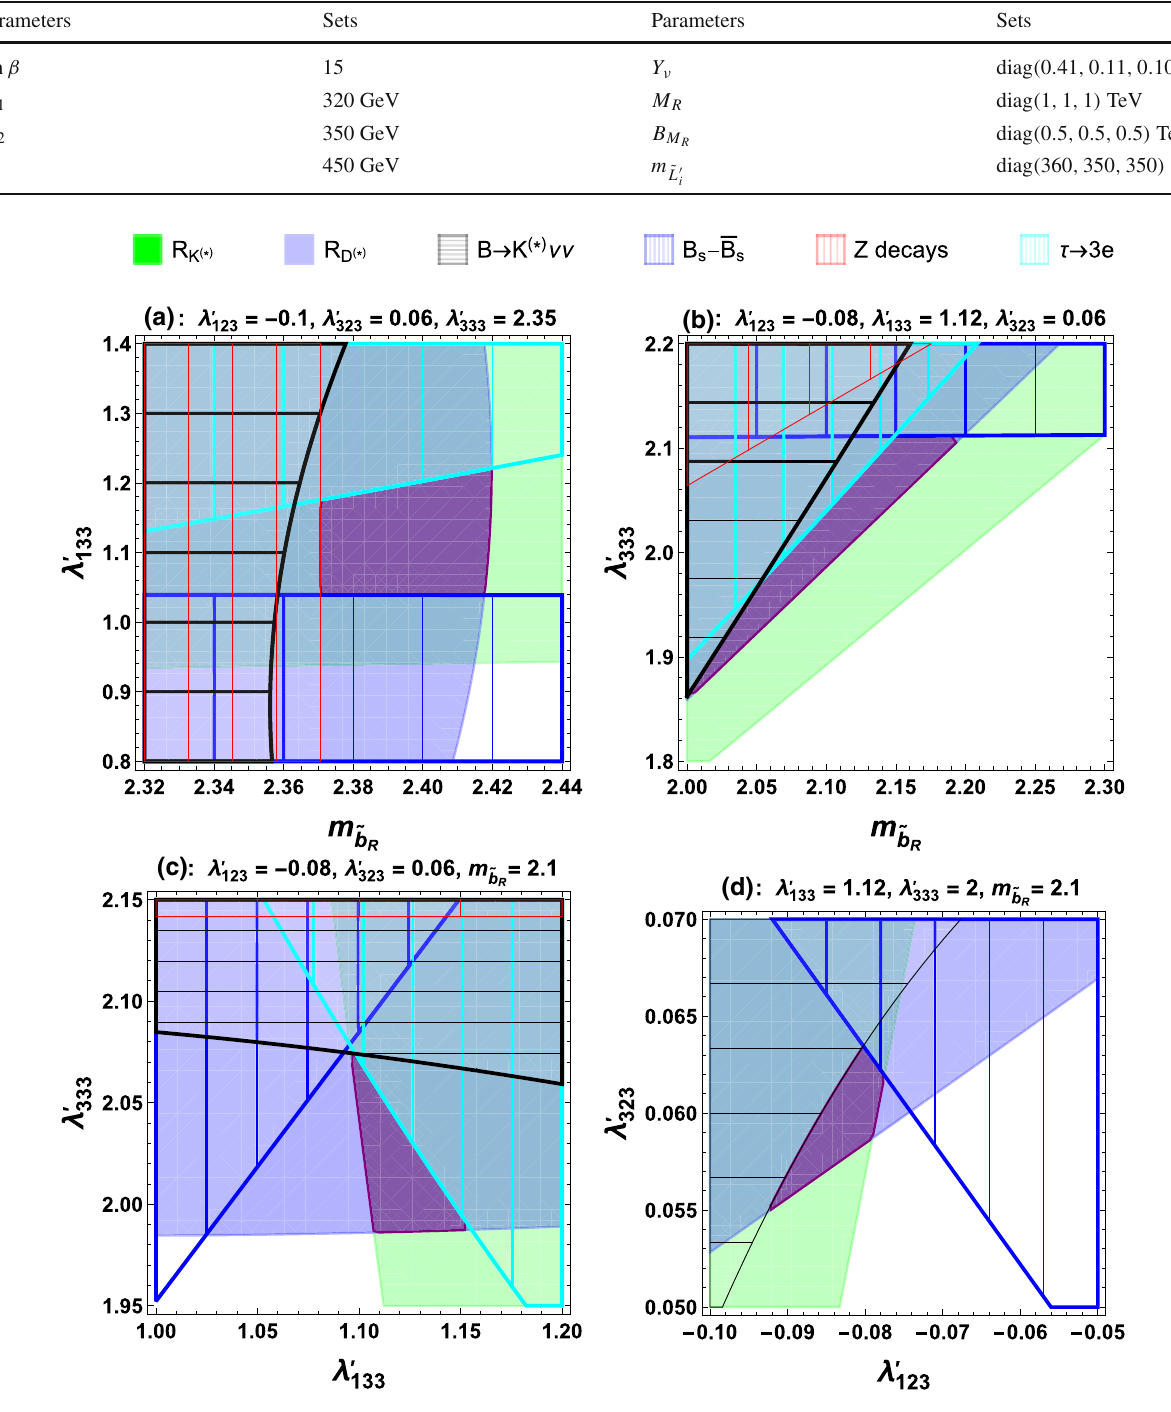
Fig. 1 The experimental allowed regions for explaining the R K ( ∗ ) and R D ( ∗ ) anomalies in Case A. The masses m ˜ TeV. The 2 σ favored areas for R K ( ∗ ) and R D ( ∗ ) measurements are denotedbygreenandblue,respectively.Thehatchedareasfilledwiththe